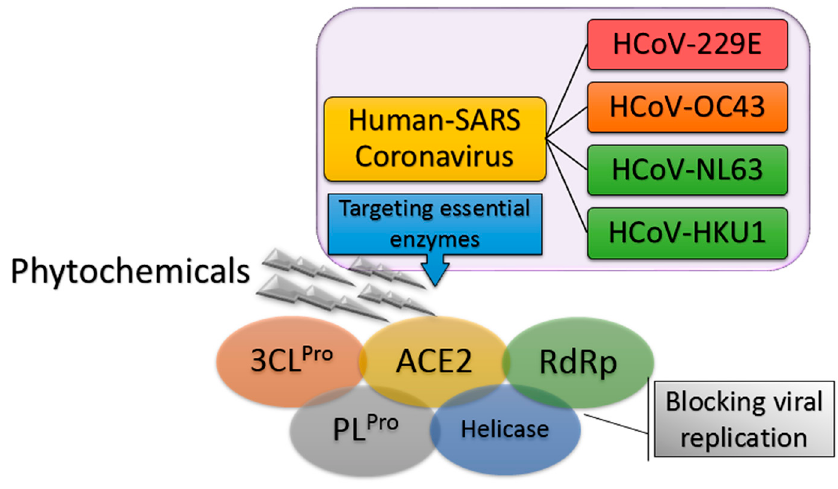
Figure 1. General overview of inhibition of severe acute respiratory syndrome coronavirus (SARS- CoV) replication.